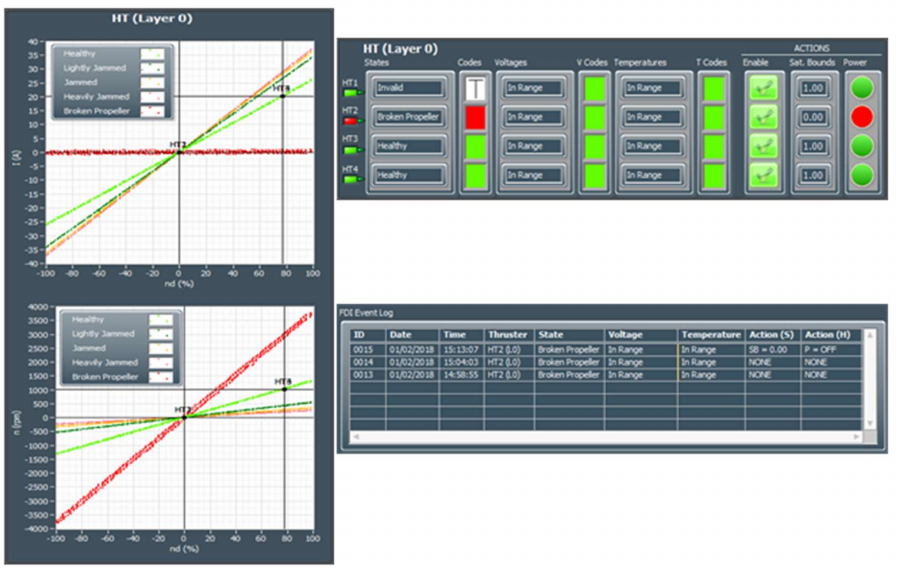
Figure 26. Test 3 (Closed-Loop): Total fault in HT2 (“Broken Propeller”) with enabled fault